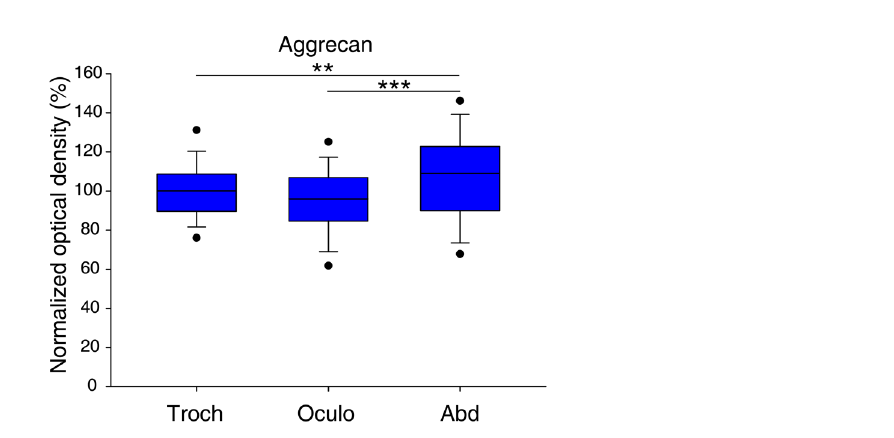
Figure 5. Optical densities of aggrecan reactions in the trochlear-, oculomotor- and abducens nuclei. Optical densities were normalized by the mean optical density of PNNs in the trochlear nucleus and expressed as percentages of this mean. Box plots represent the 10th, 25th, 50th 75th and 90th percentile values, lower and upper closed circles mark the 5th and 95th percentiles. There is a statistically significant difference in optical densities among the three nuclei (Kruskal–Wallis ANOVA on Ranks test, p < 0.001). Pairwise comparisons of optical densities showed statistically significant difference between two pairs of nuclei (Dunn’s post hoc test, oculomotorius vs. abducens ***p < 0.001 and trochlear vs. abducens **p = 0.007). No statistically significant difference was found between optical densities of trochlear- and oculomotor nuclei (Dunn’s post hoc test, p =